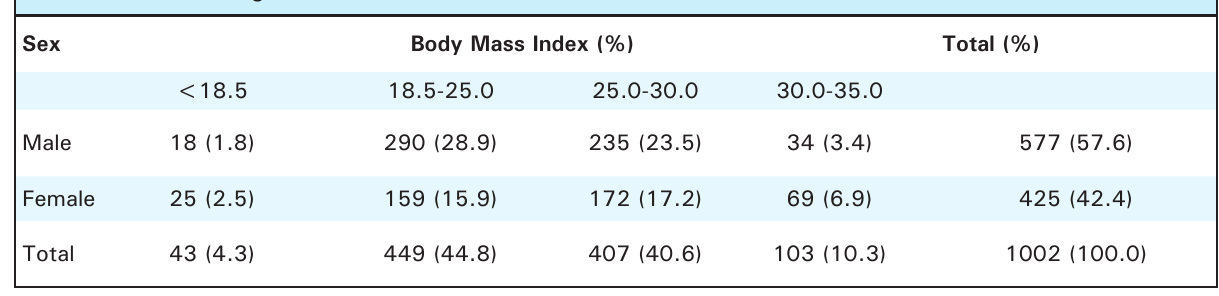
Table 2. BMI according to sex.